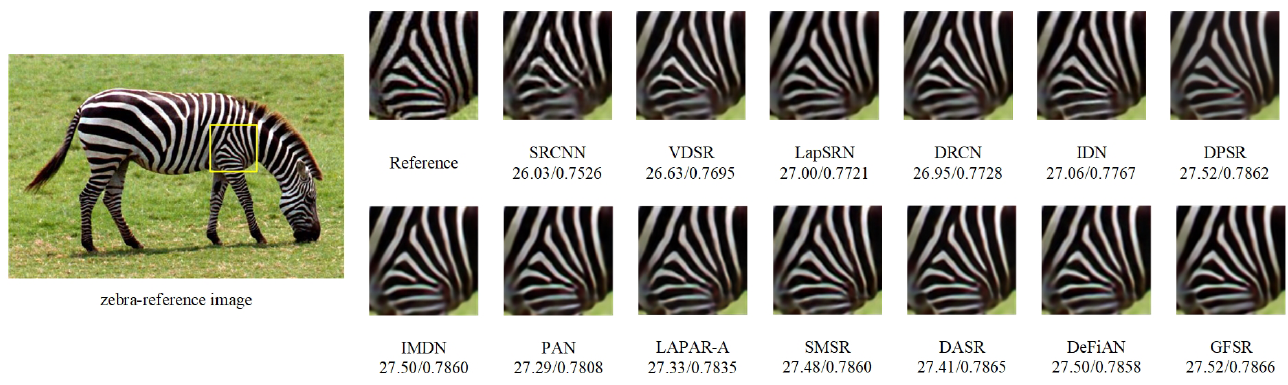
Figure 9. Visual comparison of super-resolution results of ‘Zebra’ (Set14) obtained by different SR algorithms with scaling factor